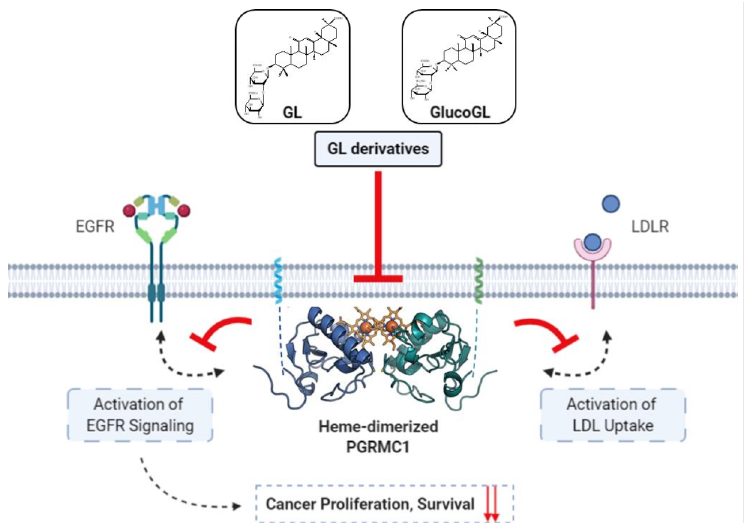
Figure 7. Schematic model showing the inhibition of PGRMC1-mediated function by GL derivatives in cancer cells. Heme-dimerized PGRMC1 contributes to cancer proliferation and chemoresistance via activation of EGFR signaling and LDL uptake through direct interaction with EGFR or LDLR. GL derivatives specifically bind to heme-dimerized PGRMC1 and inhibit the interaction of PGRMC1 with EGFR or LDLR, thereby suppressing PGRMC1-mediated cancer proliferation and